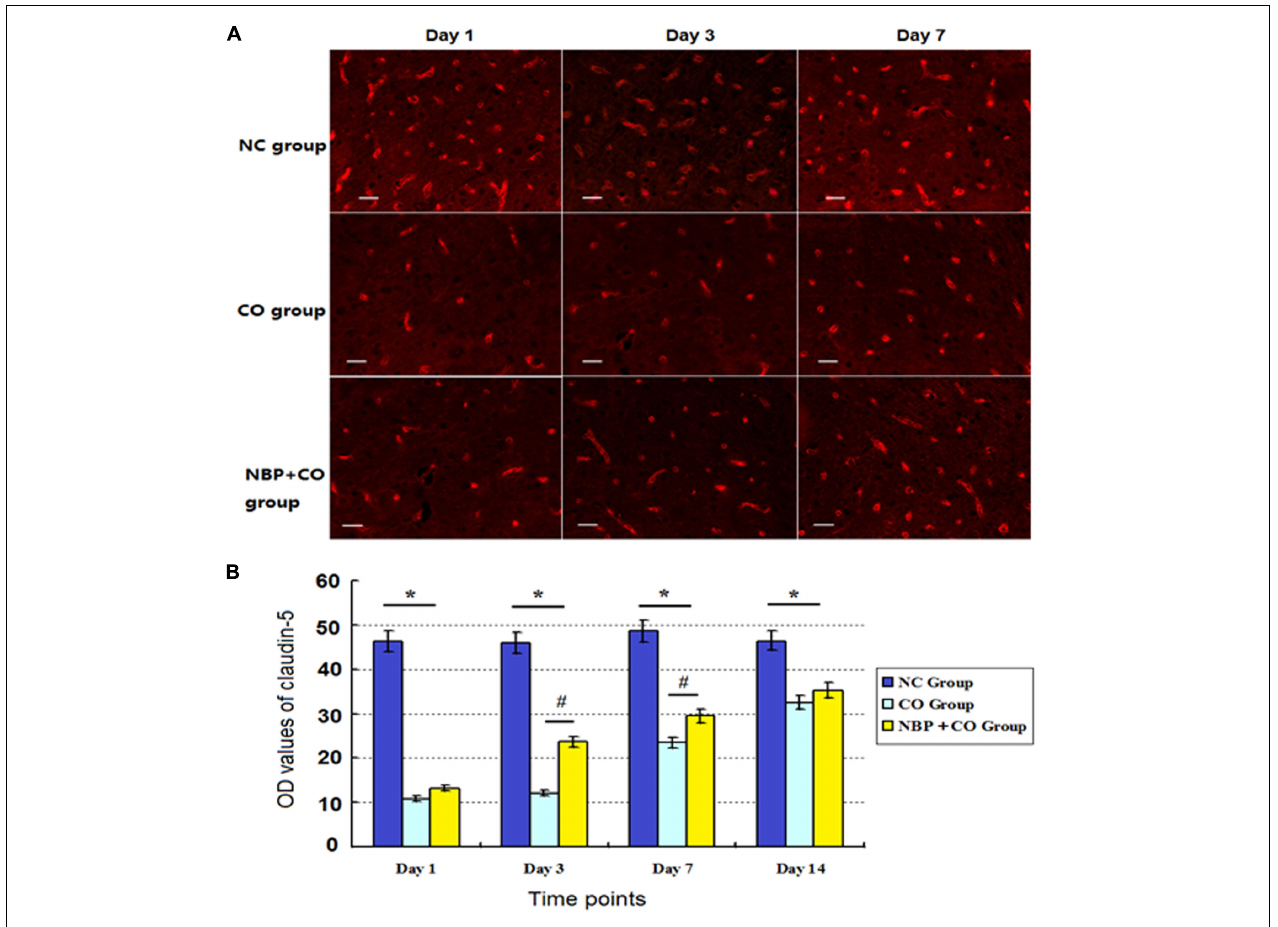
FIGURE 6 | Changes of claudin-5 expression in NC, CO and NBP + CO groups. A large number of claudin-5-positive vessels were observed in NC subjects, and the positive levels of claudin-5 protein were notably reduced on day 1, followed by gradually restoration to approximate normal level on day 14 in CO group. The levels of claudin-5-positive vessel in NBP + CO group were higher than that in CO group ( n = 4, P < 0.05). (A) The expressions of claudin-5 positive cells in each group; (B) The OD value alterations of claudin-5 positive cells in different groups ( n = 4). ∗ Compared with NC group, P < 0.05; # compared with CO group at the same time point, P < 0.05 ( F = 18.251 ∼ 32.817). Scale bar = 30 µ